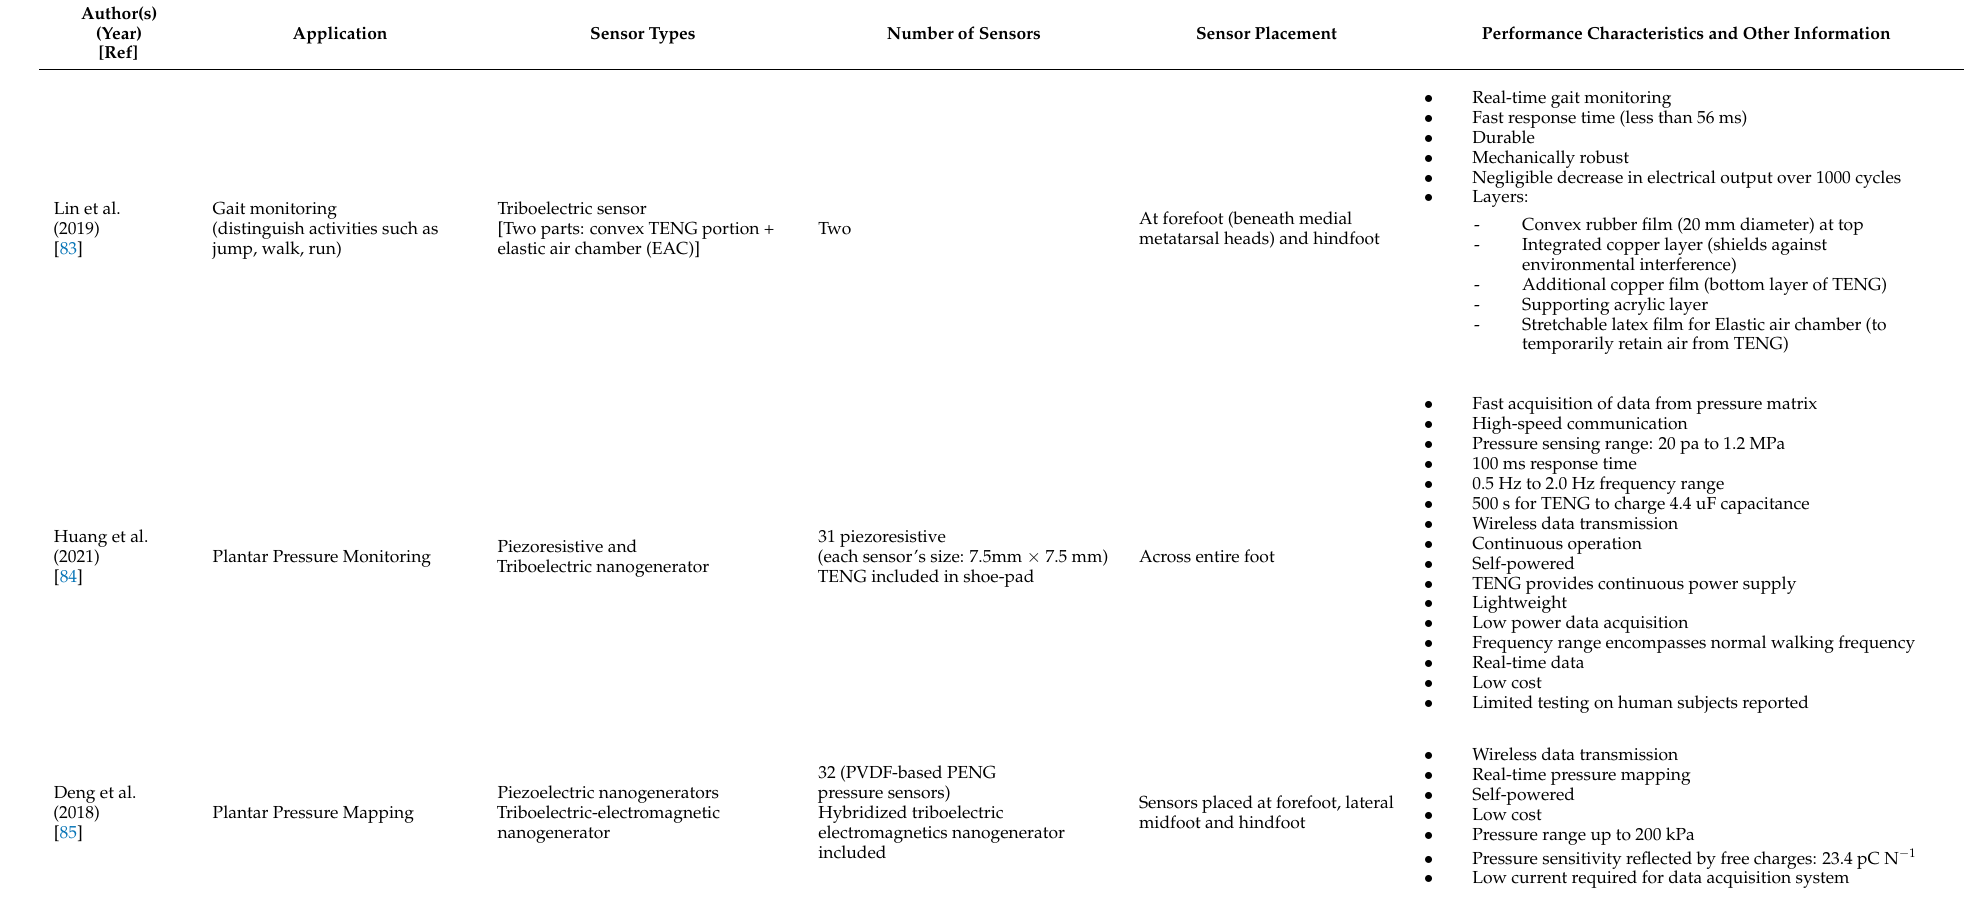
Table 2. Key points pertaining to various insole-based and related sensor systems which have incorporated triboelectric